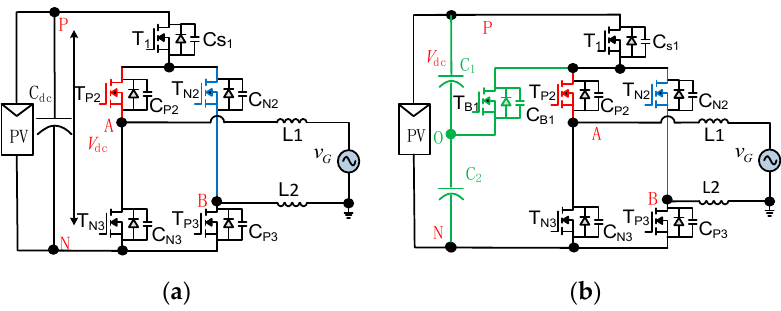
Figure 1. H5 topology without/with NPC cell. ( a ) H5 topology [11]; ( b ) Optimized H5 (OH5) [19].